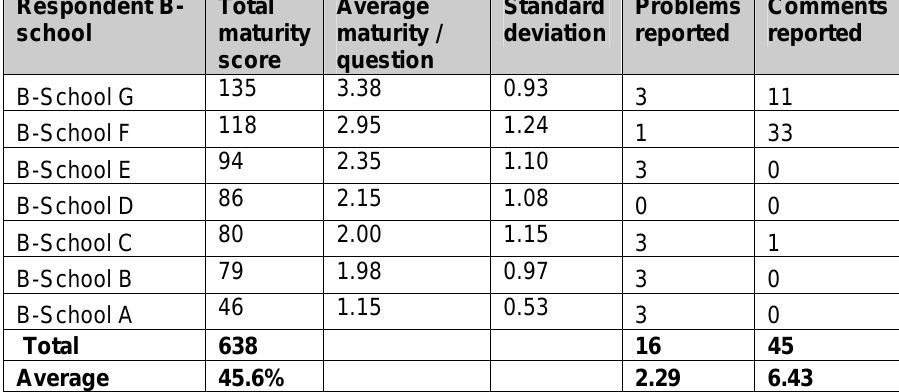
Table 4: Survey data summary by respondent schools overall maturity